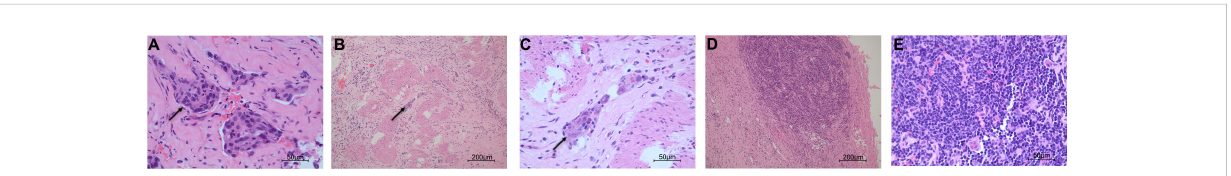
FIGURE 2 Histopathological examination of the specimens in pre- and post-olaparib treatment. (A) The cells (black arrow) from the in fi ltrating liver in pre- olaparib treatment are markedly pleomorphic with enlarged irregular nuclei (hematoxylin and eosin; magni fi cation ×400). (B, C) After treatment with olaparib, only a very limited amount of cancer cells (black arrow) remained, and intense fi brosis developed (magni fi cation ×100 in panel B and ×400 in panel (C) . (D, E) The resected lymph node was negative for malignancy (magni fi cation ×100 in panel D and ×400 in panel E ).